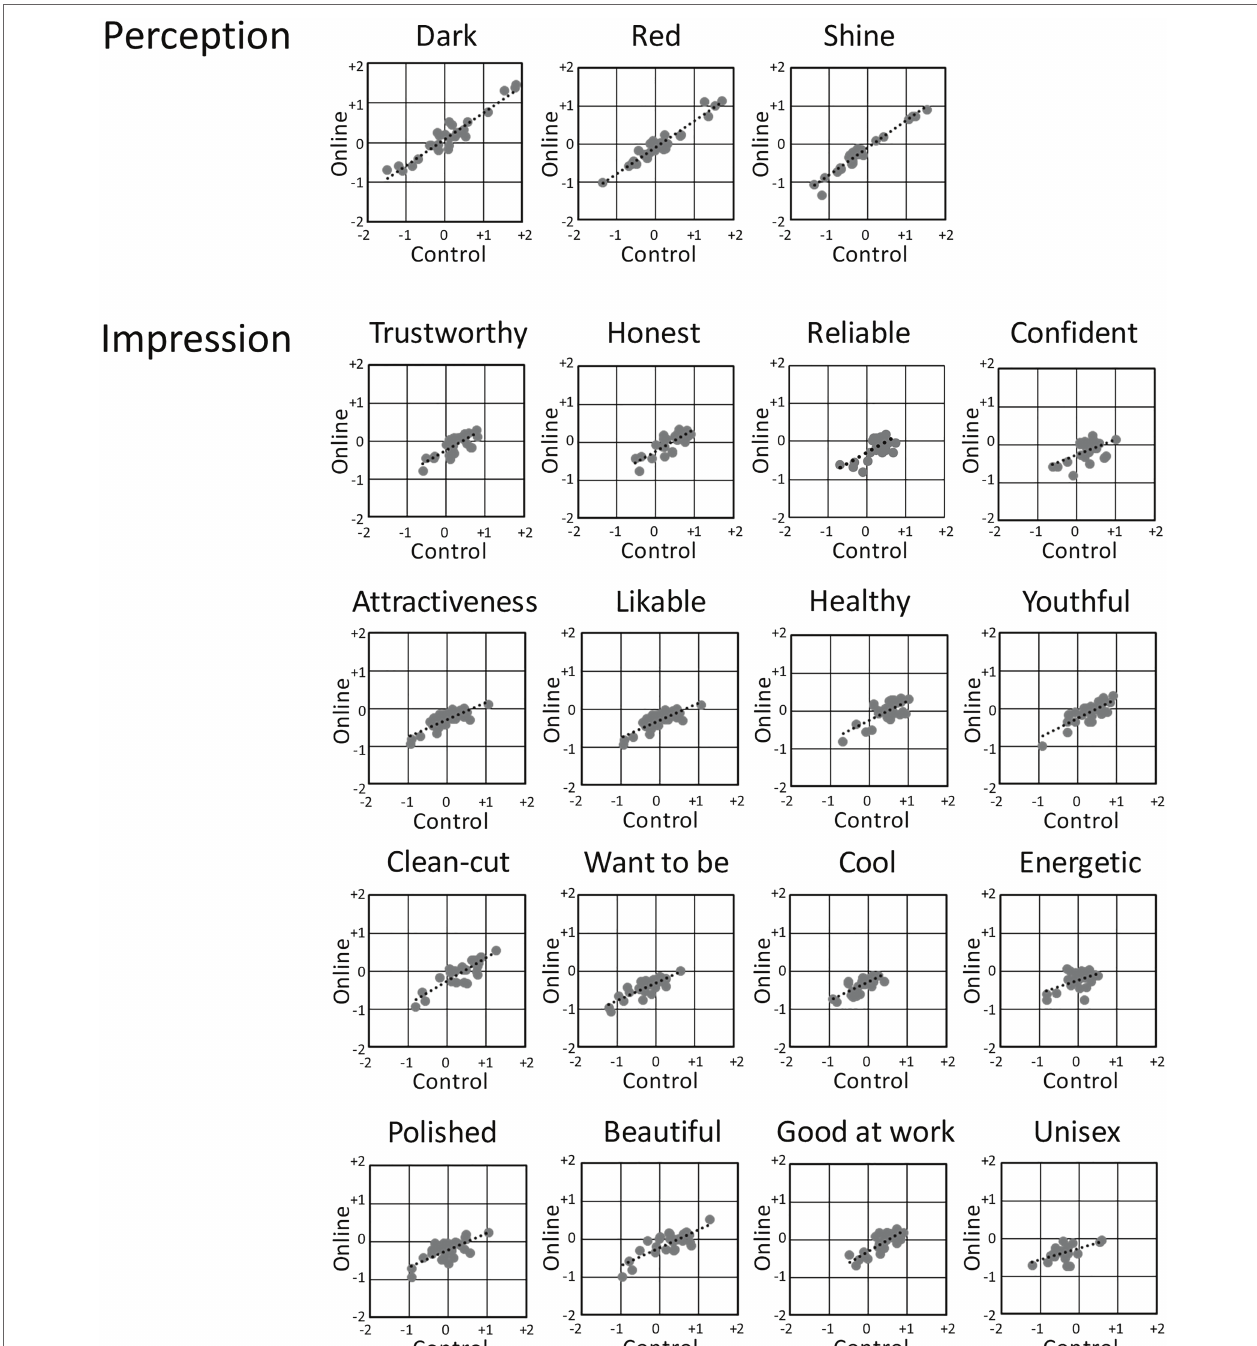
FIGURE 2 | Correlation between the Online1 and Control averaged scores for each questionnaire item for 28